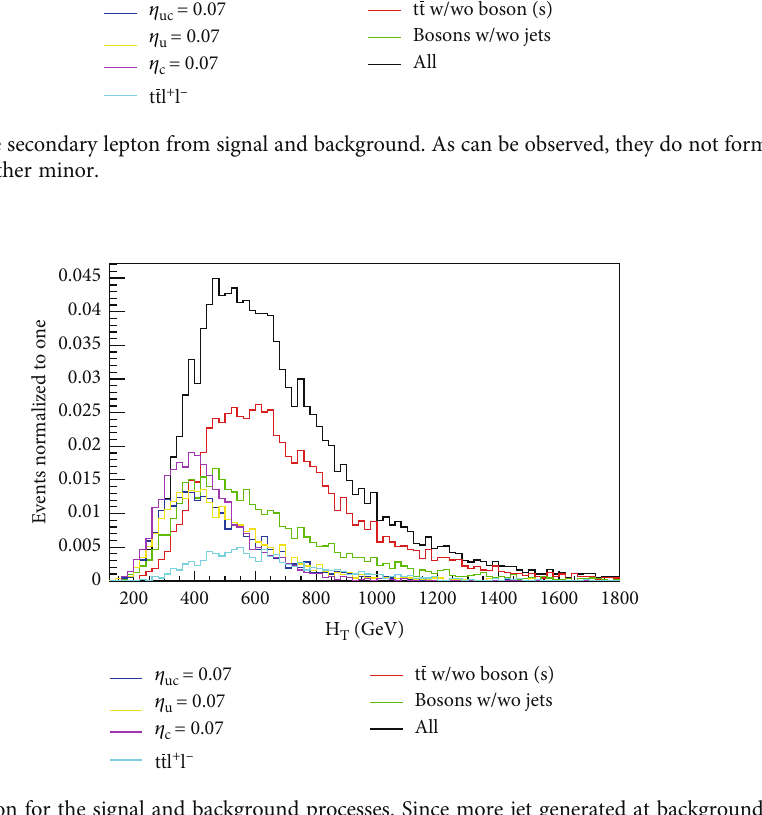
Figure 11: Scalar H distribution for the signal and background processes. Since more jet generated at backgrounds, they have relatively T shifted to